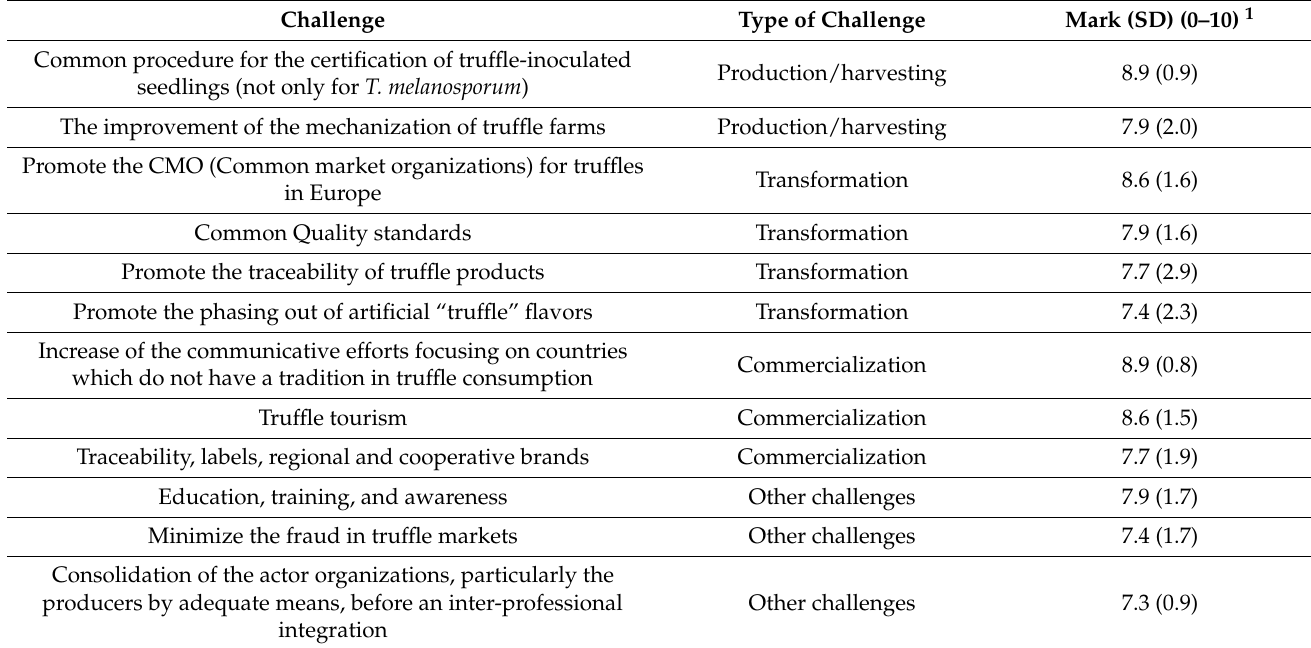
Table 3. Top ranked challenges of the truffle sector identified by the truffle expert panel at the end of the second round (only marks higher than 7 have been included in the